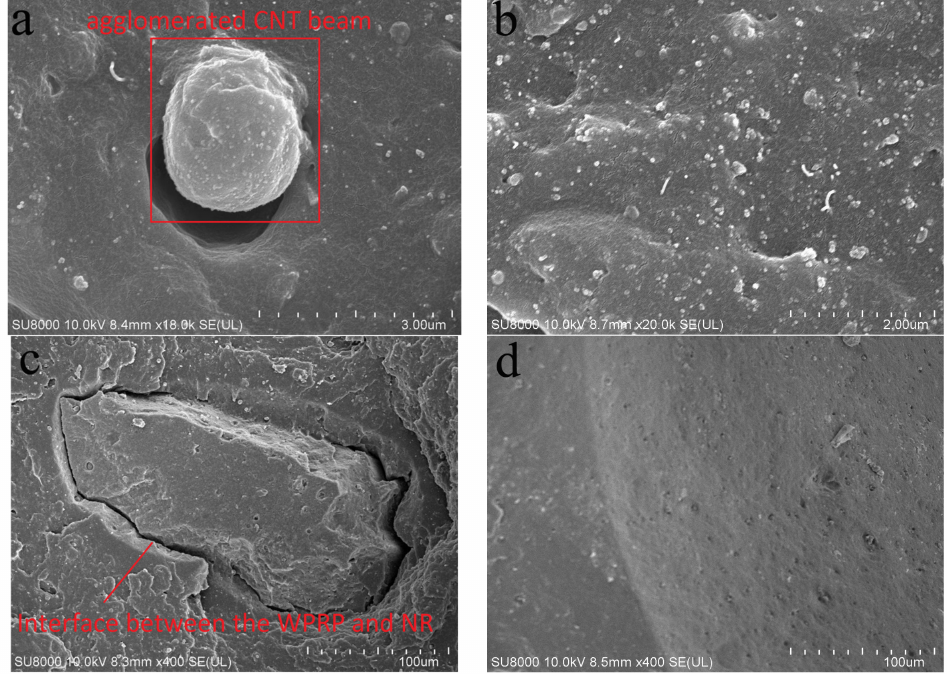
Figure 3. SEM images of ( a ) CNT/NR composites; ( b ) CNT/WPRP/NR composites with Xanthium- like CNT/WPRP mixtures ( × 20,000); ( c ) CNT/WPRP/NR composites with un-pre-dispersed CNT and WPRP; and ( d ) CNT/WPRP/NR composites with Xanthium-like CNT/WPRP mixtures ( ×